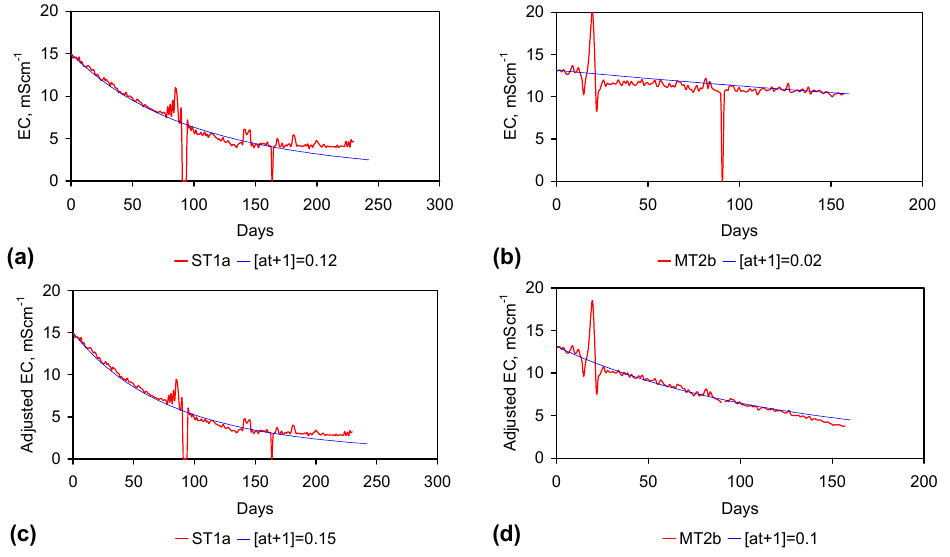
Figure 4. Example EC changes vs. time. ( a ) ST1a; ( b ) MT2b; ( c ) ST1a, adjusted for